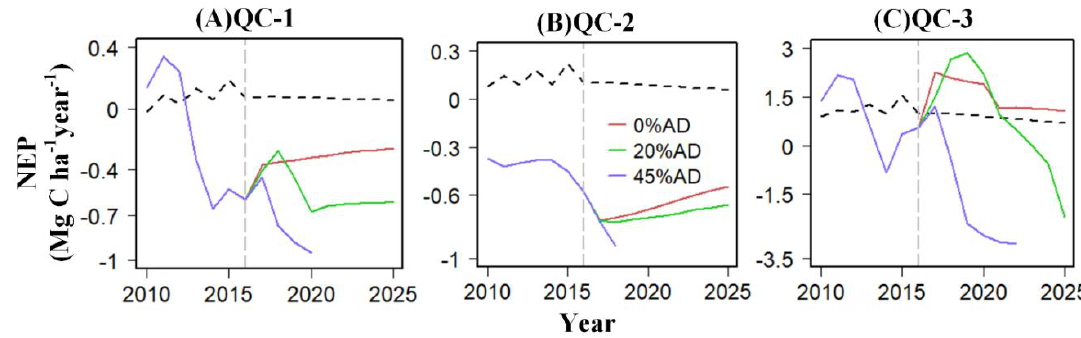
Figure 6. Simulated NEP from 2010 to 2016 (on the left side of the vertical dotted line) and predicted NEP under three different defoliation levels (0% AD, 20% AD and 45% AD) from 2017 to 2025 (on the right side of the vertical gray dotted line) for the QC1 ( A ), QC2 ( B ), and QC3 ( C ) sites. Horizontal dotted line represent results for disturbance (control).